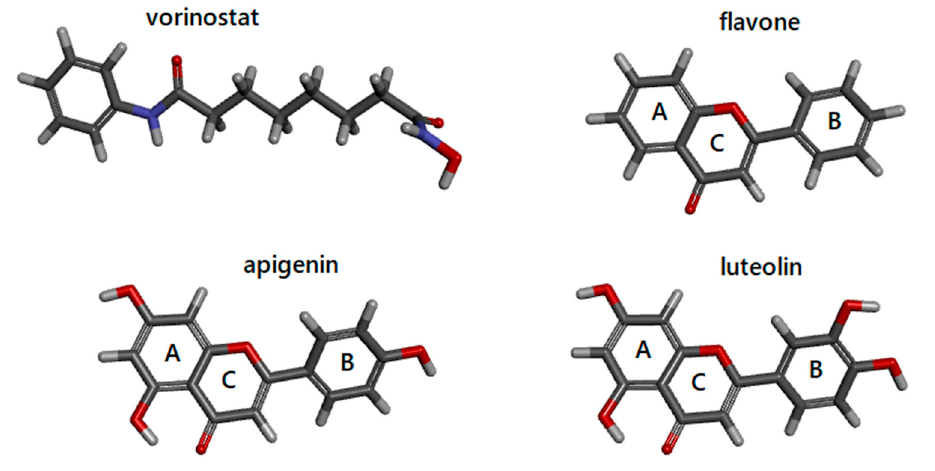
Figure 1. Molecular structures of vorinostat, flavone, apigenin, and luteolin are from the PubChem database. A, B, and C indicate the different rings of flavones. Images are generated by DiscoveryStudio4.5.